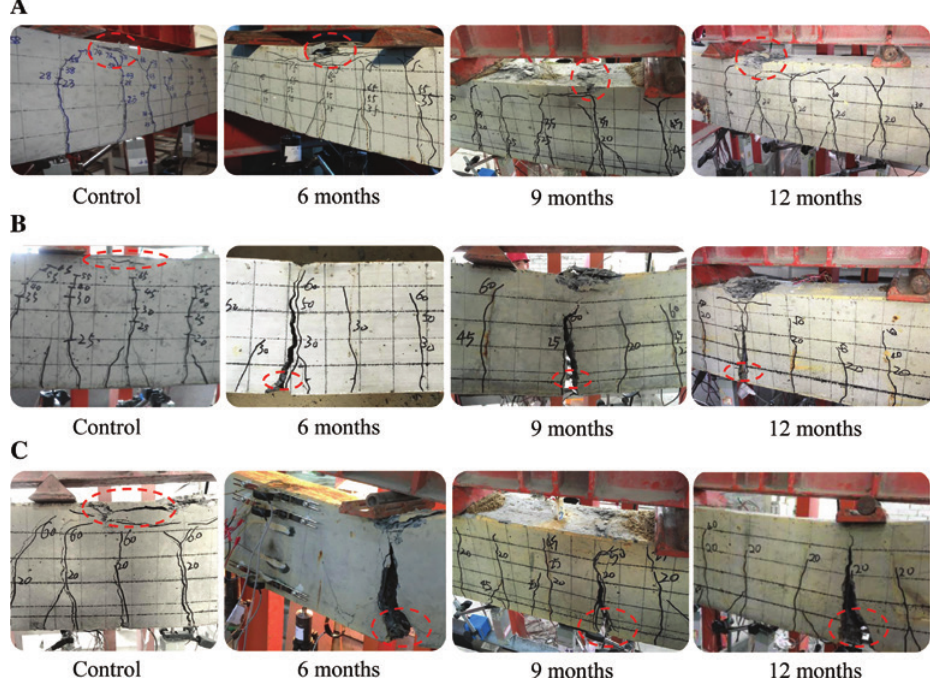
Figure 5: Typical failure modes of beams. (A) Steel bars RC beams, (B) BFRP bars RC beams and (C) SFCBs RC beams.